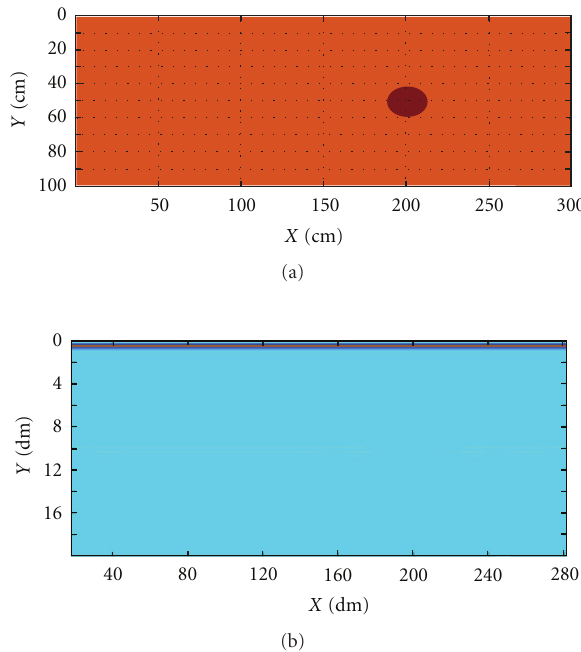
Figure 5: (a) Circular dielectric scatterer located within the wall, (b) corresponding